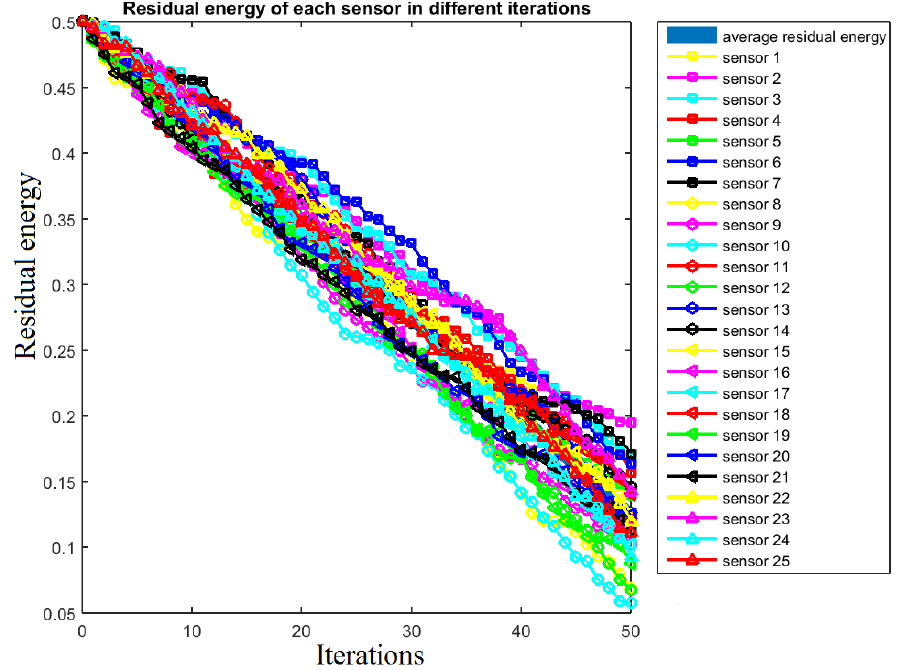
Figure 8. Residual energy of each sensor for 50 iterations.